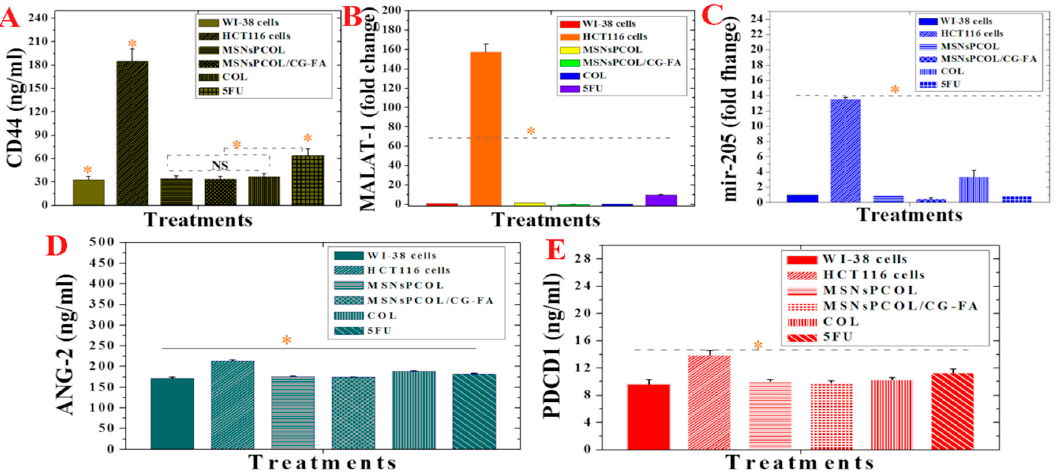
Figure 11. ( A ) MALAT-1 protein expression in normal WI-38 cells, HCT116 cells, and HCT116 cells treated with proposed delivery and 5-FU. ( B ) mir-205 expression in normal WI-38 cells, HCT116 cells, and HCT116 cells treated with proposed delivery and 5-FU. ( C ) Ang-2 protein expression in normal WI-38 cells, HCT116 cells, and HCT116 cells treated with proposed delivery and 5-FU. ( D ) CD44 protein expression in normal WI-38 cells, HCT116 cells, and HCT116 cells treated with proposed delivery and 5-FU. ( E ) PD-1 protein expression in normal WI-38 cells, HCT116 cells, and HCT116 cells treated with proposed delivery and 5-FU. Note: An orange asterisk (*) indicates significant ( p < 0.05) differences between tested samples, whereas a blue asterisk (*) indicates significant differences between specific samples. NS, not significant. All data are expressed as mean ± SD.